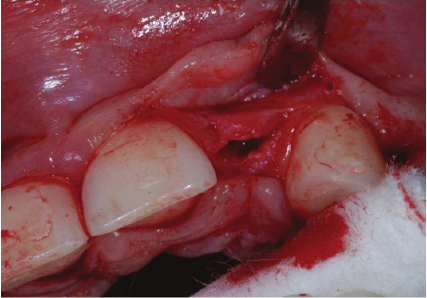
Figure 4: Flap incision in site to the right.